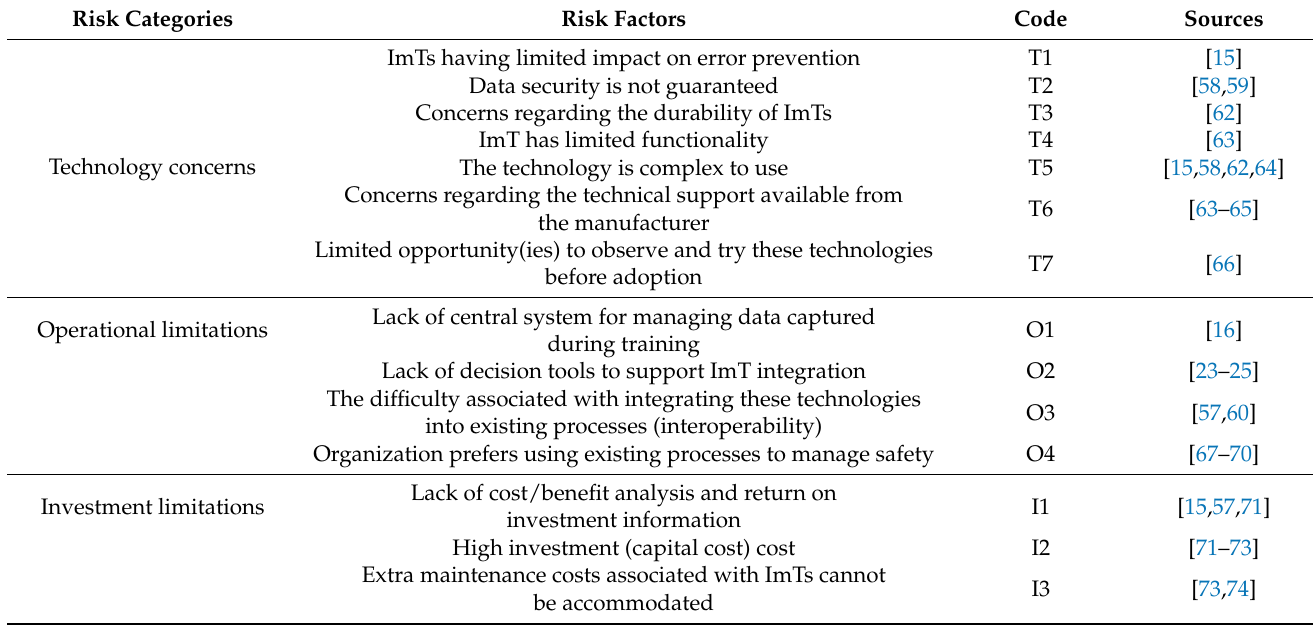
Table 1. Risk factors associated with immersive reality technology